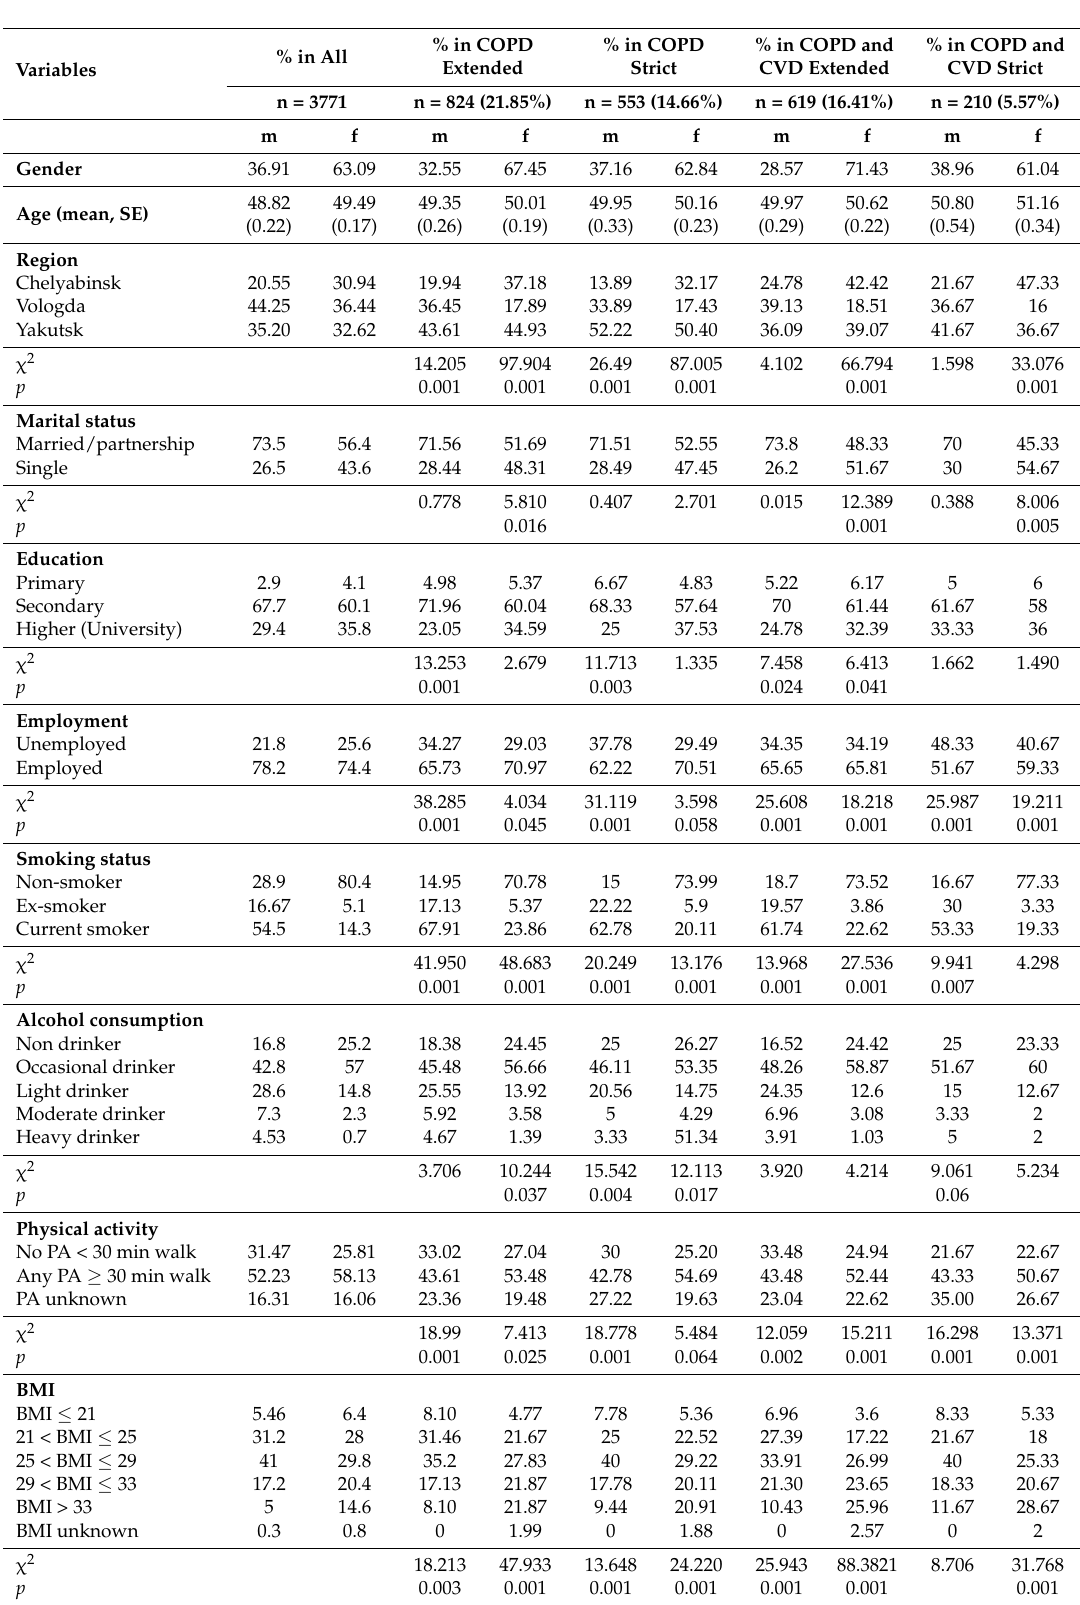
Table 2. Prevalence of risk factors in different chronic obstructive pulmonary disease (COPD), and combined COPD and cardiovascular diseases (CVD)